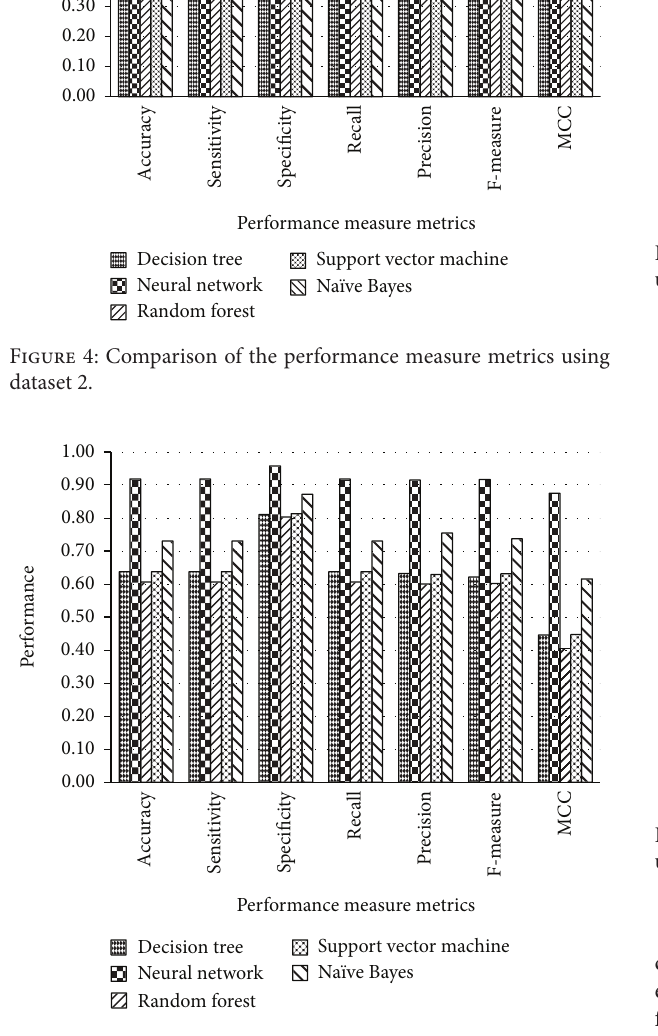
Figure 5: Comparison of the performance measure metrics using dataset 3.